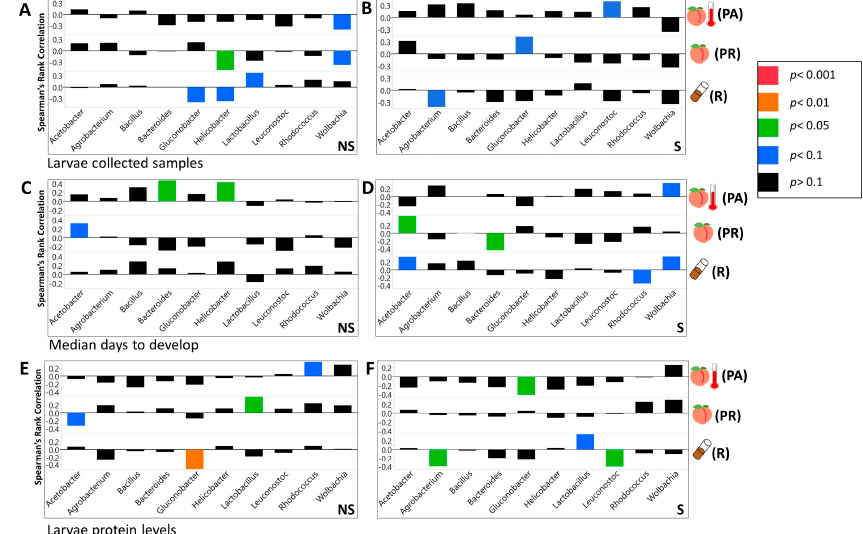
Figure 7. The correlations between the abundance of bacterial taxa and larvae life history traits and metabolic phenotypes vary with the larval diet. Spearman’s rank correlation coefficients between the abundance of 10 dominant symbiotic bacterial genera and larvae phenotypes on each diet. The color of the bars corresponds to the level of significance (uncorrected for multiple comparisons) for each correlation. ( A ) Total proportion of NS larvae reaching the 3rd instar stage; ( B ) total proportion of S larvae reaching the 3rd instar stage; (C) median number of days to reach pre-pupation stage for NS larvae; ( D ) median number of days to reach prepupation stage for S larvae; ( E ) protein concentrations of NS larvae; and ( F ) protein concentrations of S larvae. Symbiotic bacteria may influence life history traits and protein concentrations of the larvae di ff erently depending on a